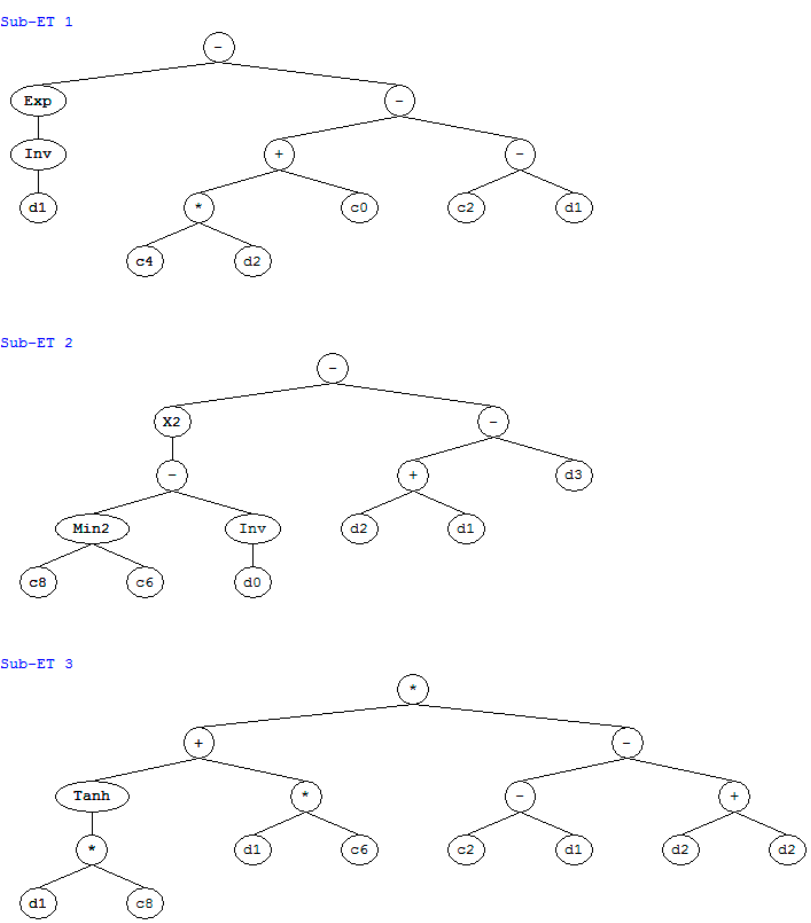
Figure 1. Expression tree for strength. Materials 2019 , 12 , x FOR PEER REVIEW